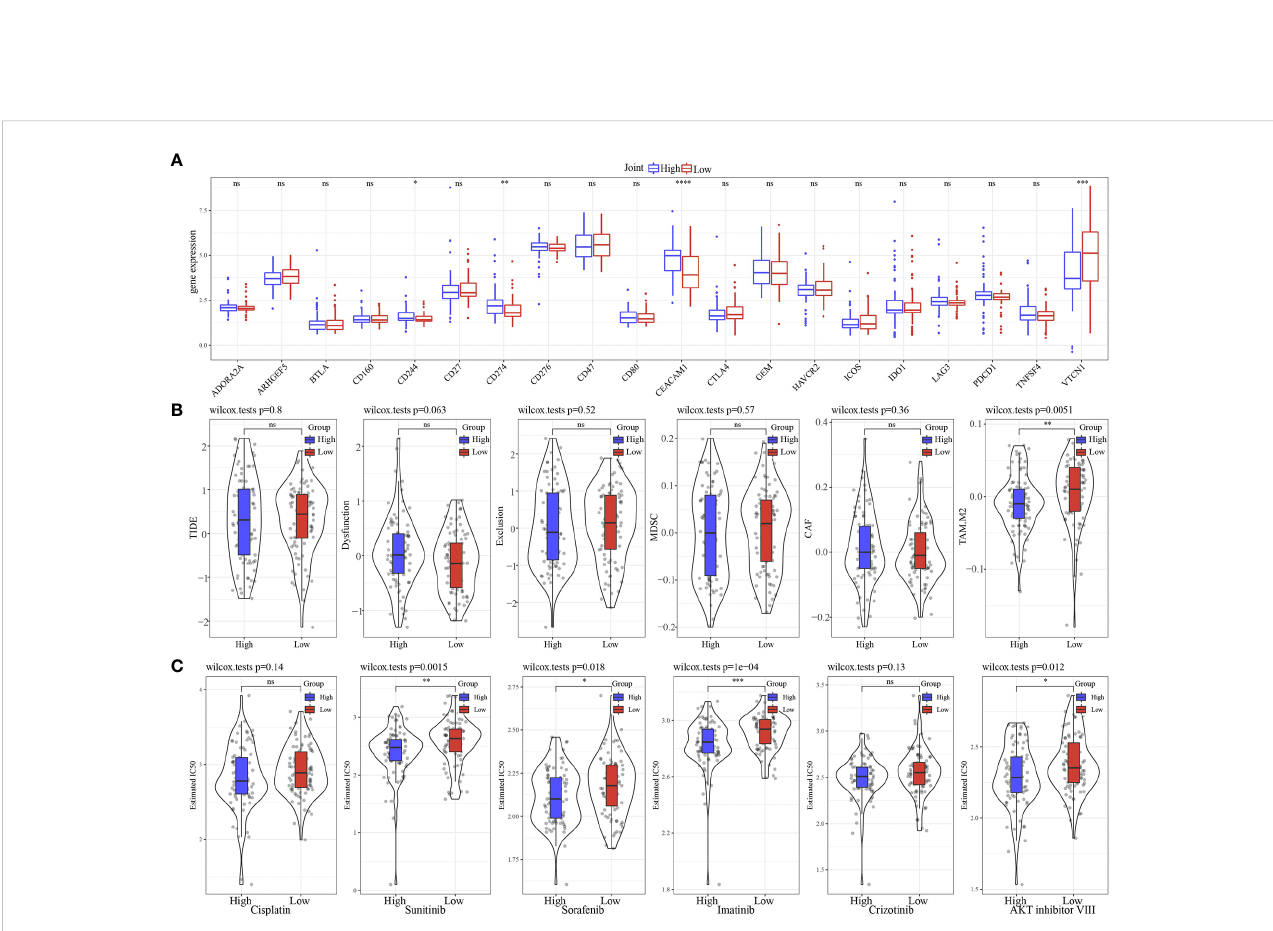
FIGURE 11 Immunotherapy analysis. (A) The expression levels of 20 immune checkpoint genes in high group and low group. (B) TIDE analysis in high group and low group. (C) The box plots of the estimated IC50 for Cisplatin, Sunitinib, Sorafenib, Imatinib, Crizotinib and AKT inhibitor VIII in high group and low group. * p<0.05, ** p<0.01, *** p<0.001, **** p<0.0001, ns, no